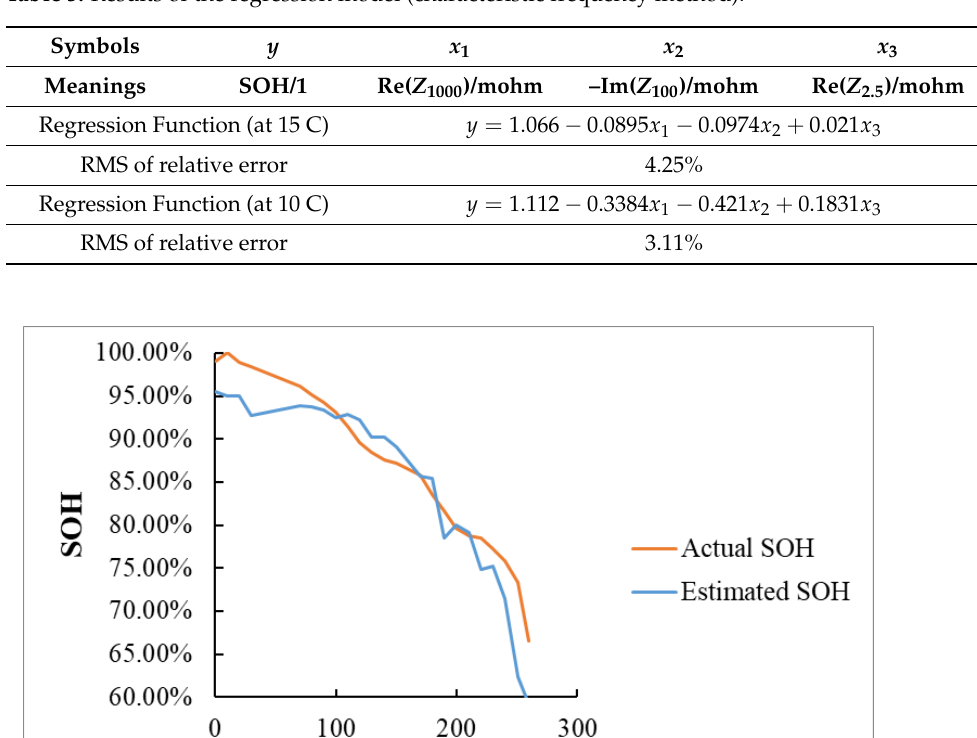
Table 3. Results of the regression model (characteristic frequency method).